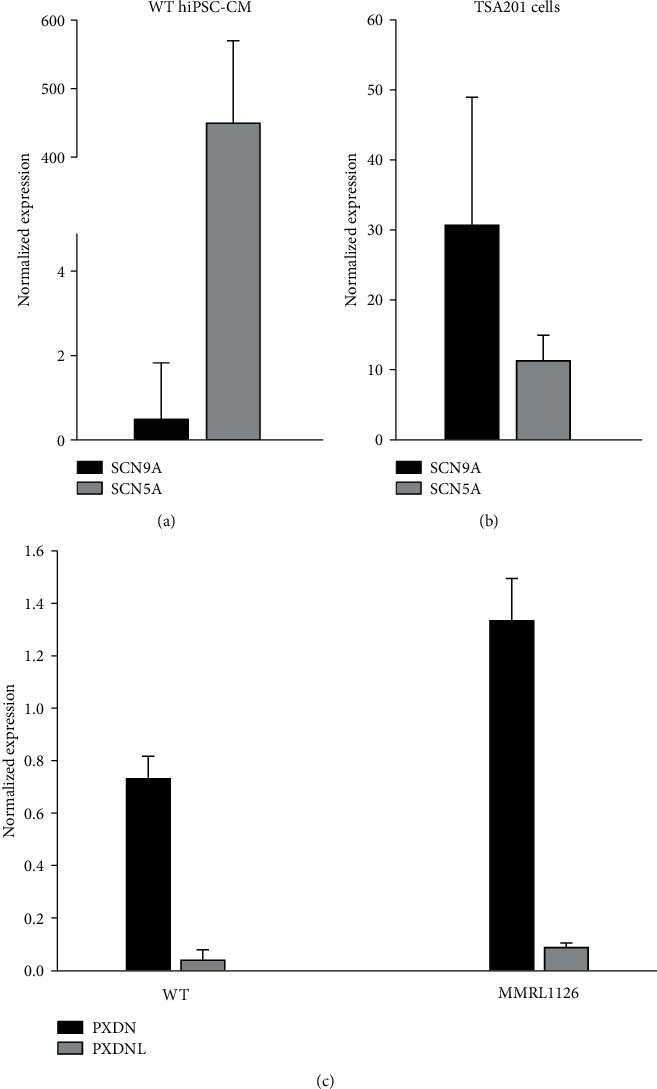
RT-qPCR analysis of SCN9A and SCN5A in hiPSC-CMs (normalized to GAPDH). SCN5A message was highly expressed, whereas levels of SCN9A were negligible in the hiPSC-CMs (a). RT-qPCR analysis of SCN9A and SCN5A in TSA201 cells transfected with SCN5A and SCN9A plasmid at a 1 : 1 molar ratio. SCN9A message could readily be detected in transfected TSA201 cells (b). RT-qPCR analysis of PXDN and PXDNL in hiPSC-CMs (c). PXDNL was expressed at low levels in both WT and MMRL1126 hiPSC-CMs.